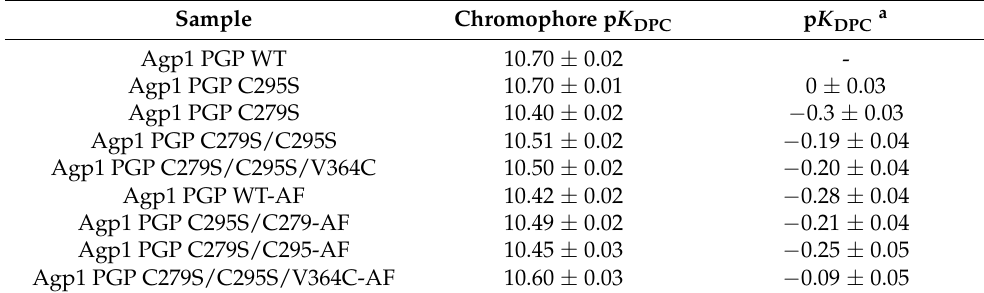
Table 1. Comparison of p K a values of biliverdin chromophore deprotonation (p K DPC ) of the different AF-labeled and unlabeled Agp1-PGP variants from Figures 5 and 6. The standard error is given ( ± SD). Sample Chromophore p K